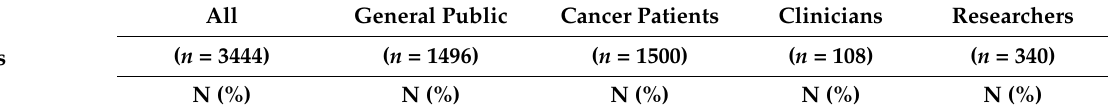
Table 4. Multivariate logistic regression analysis of variables associated with intent to undergo risk- reducing